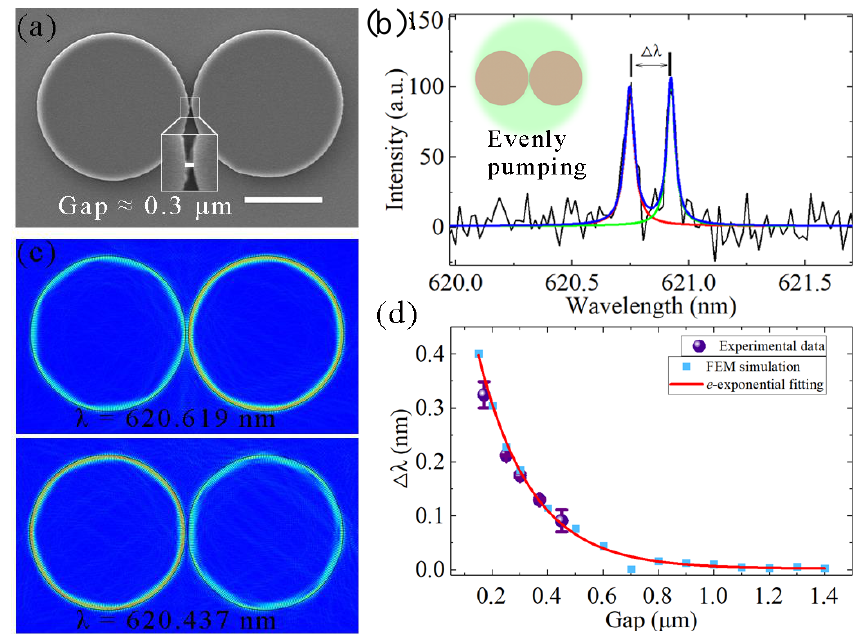
Figure 5. ( a ) SEM image of the coupled microdisks. Gap between two microdisks is approximately 0.3 µ m. Scalebaris10 µ m. ( b )Laserspectraofcoupledmicrodiskswith0.3 µ mgap. ∆ λ denotesthedistancebetween twopeaksofmodesplitting. Insert: schematicofevenlypumpingschemes. ( c